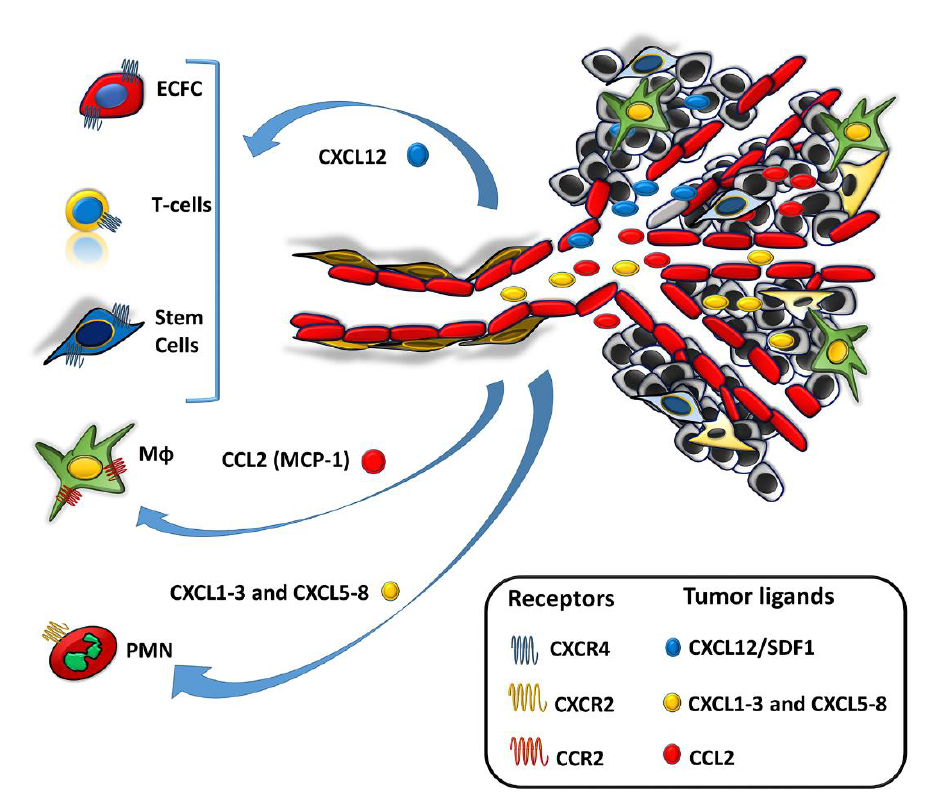
Figure 2. The main chemokine / chemokine-receptor axes involved in cell recruitment at the tumor site. Both tumor cells and cells of the tumor microenvironment [endothelial cell, monocytes / M φ (tumor associated macrophages, TAM), mesenchymal stem cells (MSCs), fibroblasts (cancer associated fibroblasts, CAFs)] release chemokines that recruit circulating cells into the tumor mass. Such chemokines interact with chemokine receptors expressed on circulating cells. The CXCL12 chemokine (SDF-1, stromal derived growth factor) recruits cells expressing the CXCR4 receptor: all the stem cells, [neural stem cells, induced pluripotent stem cells (iPSCs), mesenchymal stem cells (MSCs)], T lymphocytes, and endothelial colony-forming cells (ECFCs). The CCL2 chemokine [monocyte chemoattractant protein-1 (MCP-1)] recruits monocytes / M φ that express the CCR2 receptor. The CXCL1-3 and CXCL5-8 chemokines recruit neutrophils that express the CXCR2 receptor. For the cell types depicted in the tumor microenvironment, please refer to the tumor components in Figure 1.